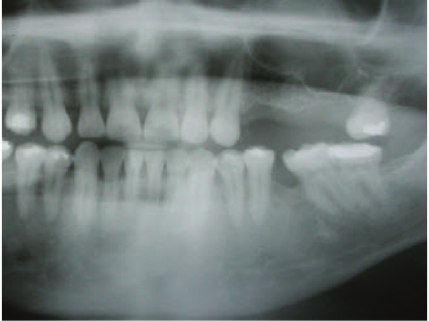
Figure2:RadiographtakenaftercompletionoftheOSFEprocedure without bone grafting with 8 mm lifting of the sinus membrane and a residual bone height of less than 3.0 mm and the amount of sinus floor